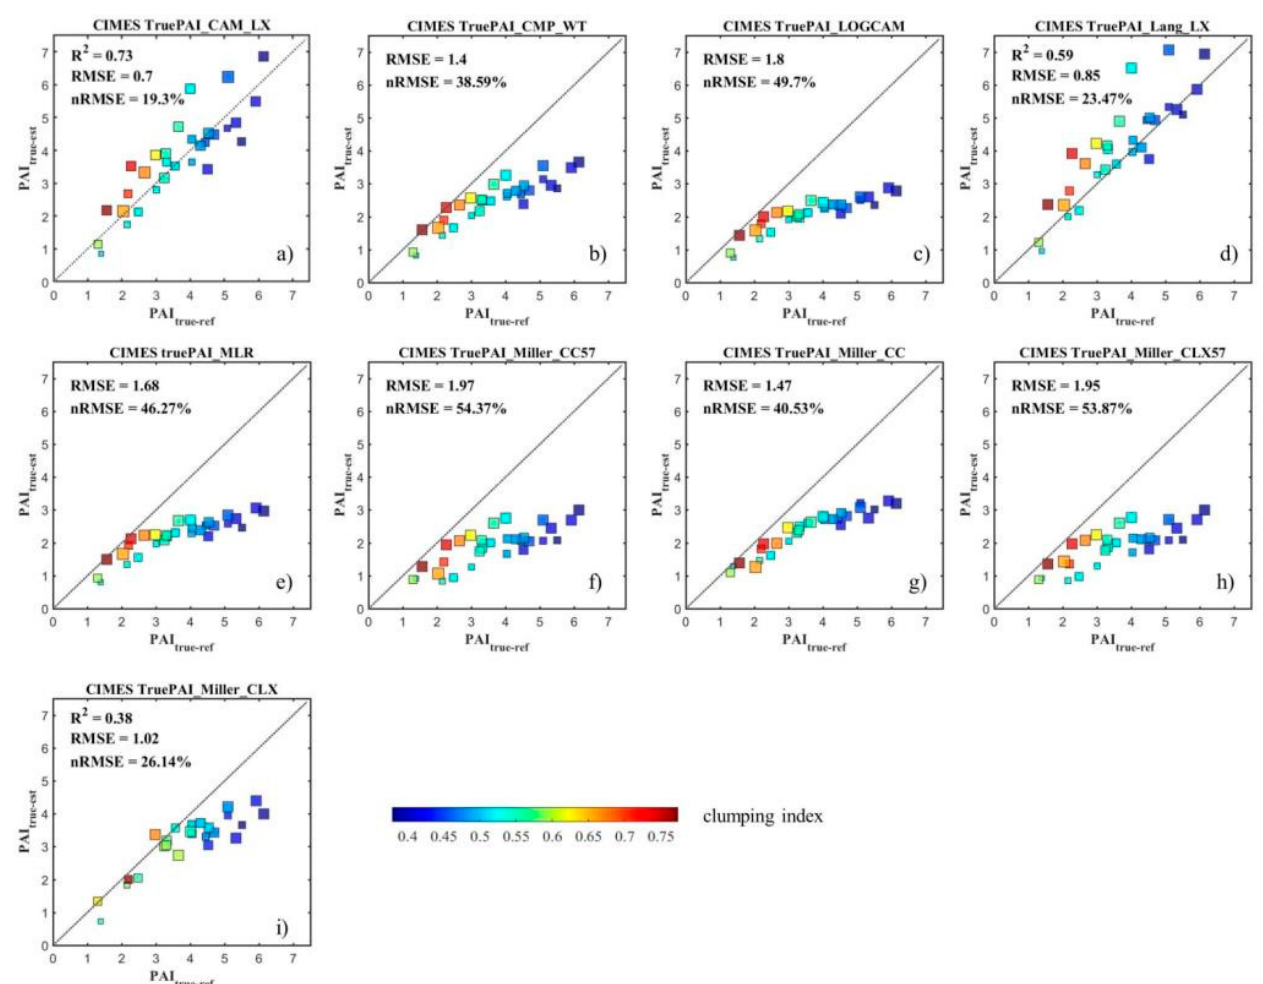
Figure 8. PAI true results from CIMES using different algorithms including the ( a ) CAM_LX, ( b ) CMP_WT, ( c ) LOGCAM, ( d ) LANG_LX, ( e ) MLR, ( f ) Miller_CC57, ( g ) Miller_CC, ( h ) Miller_CLX57, and ( i ) Miller_CLX algorithm; the best result was produced by the CIMES CAM_LX algorithm. A smaller symbol indicates a smaller average leaf inclination angle (ALA), while a larger symbol indicates a higher ALA; the Miller_CLX method only produced estimates for 26 out of 30 plots with results.